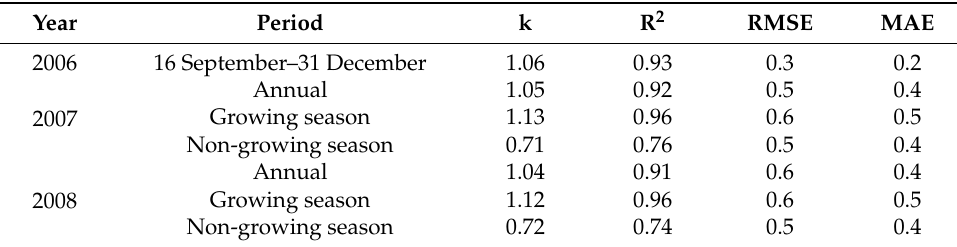
Table 5. Statistical analyses of evapotranspiration estimated by the S–W model ( ET SW ) and measured by the eddy covariance ( ET eddy ) in the different